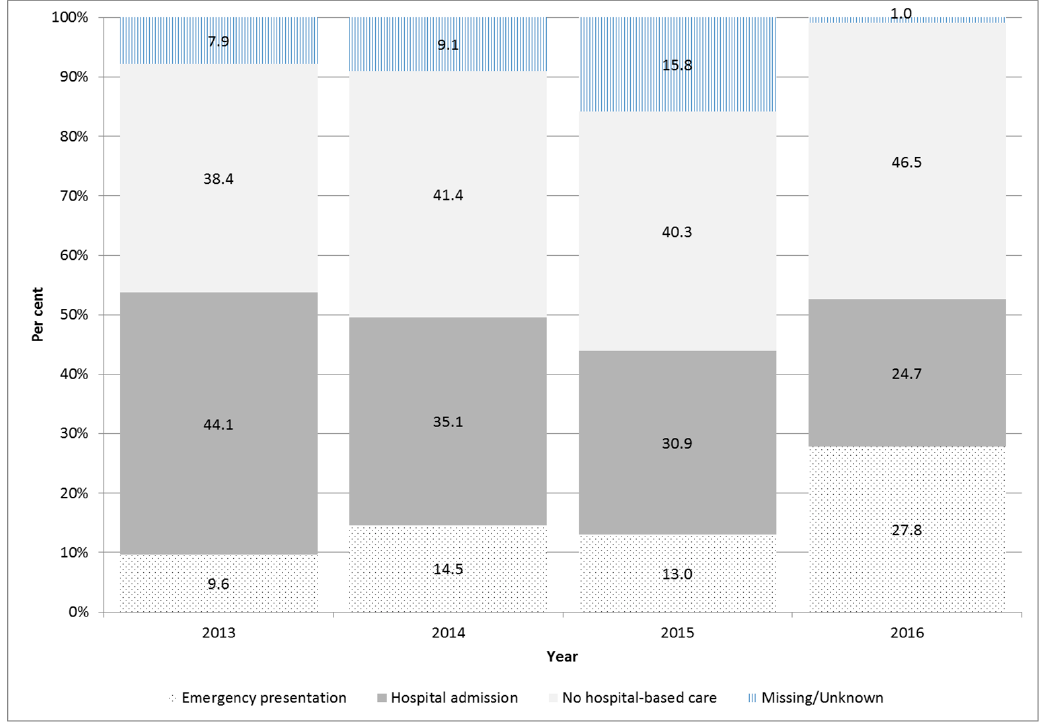
Figure 6. Proportion and type of medical care sought by dengue cases, Victoria 2013–2016.